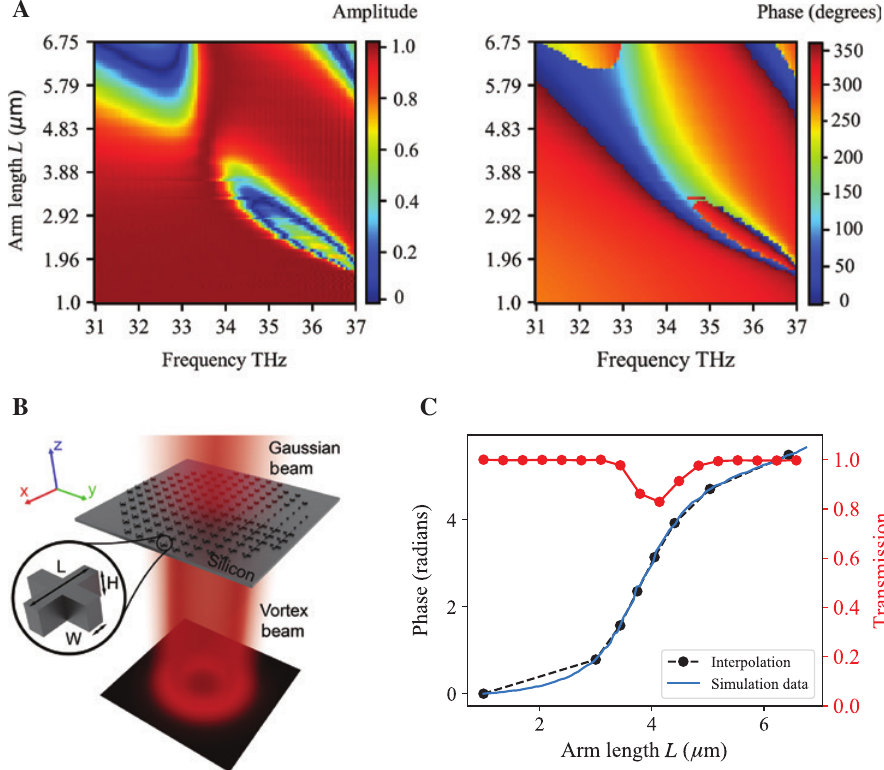
Figure 1: Meta-atom design summary and schematic layout of the Spiral Phase Plate. (A) Simulated transmission amplitudes and the corresponding transmission phases as a function of arm length L , over the frequency range 31–37 THz. Spectral position near 34 THz was selected for design of vortex generator because of the constant transmission amplitude and possibility of 2 π phase control. (B) Schematic of the vortex generator layout and silicon cross meta-atom in the inset. (C) Look-up table for IR cross-resonators. The length L of the cross-arm is varied from 1 to 6.5 μ m to achieve 0–2 π transmission for the IR